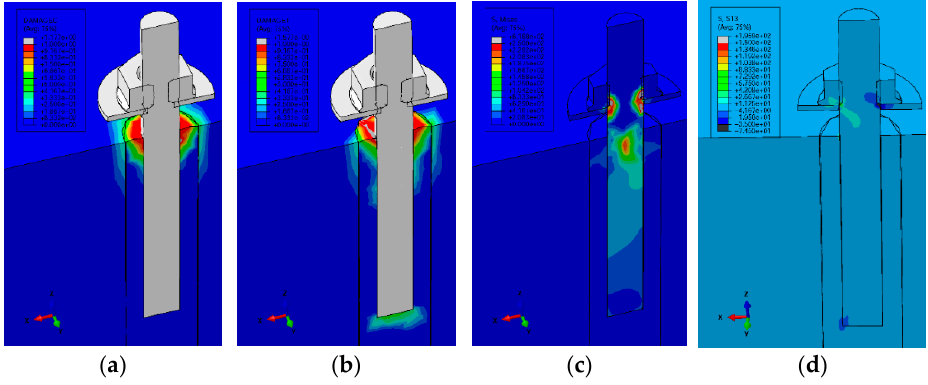
Figure 24. Contour plots of the anchor zone. ( a ) Tensile damage, d t ( b ) Compressive damage, d c ( c ) von-Mises stress, σ vm ( d ) Shear stress, σ 13 When incorporating the M24 anchor system ( (cid:1860) (cid:3032)(cid:3033) = 150 mm) into an elastic design, it is possible to increase the anchor diameter to M36 ( (cid:1860) (cid:3032)(cid:3033) = 300 mm) or M48 ( (cid:1860) (cid:3032)(cid:3033) = 450 mm). The